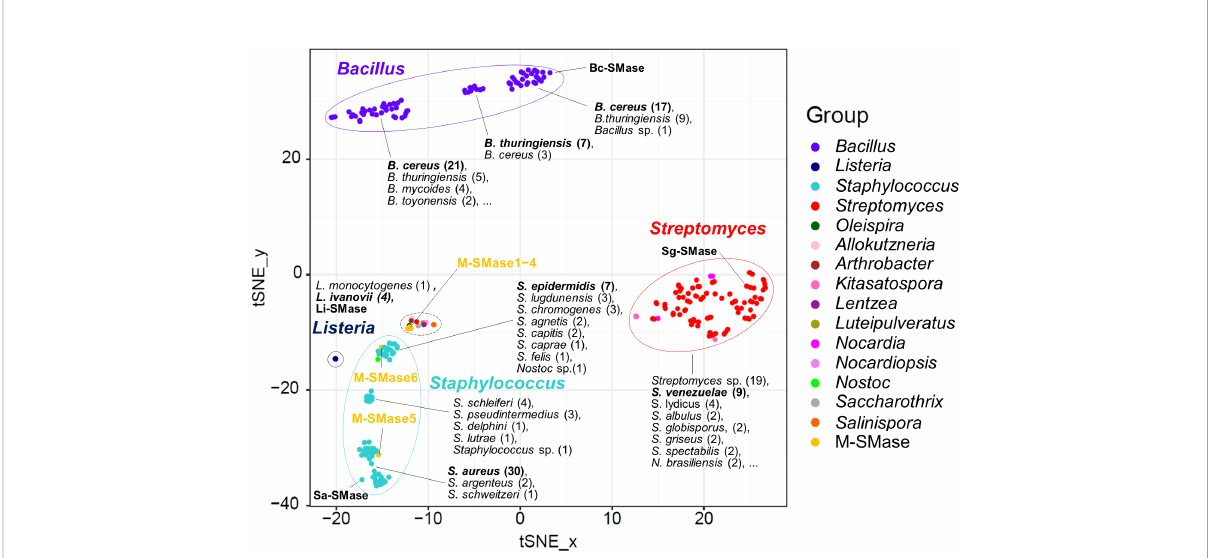
FIGURE 1 Embedding for genomic diversity of bacterial and metagenomic SMases. Protein sequence identity with four known SMases was used as a feature of t -SNE. M-SMase; metagenomic sphingomyelinase C. The number of SMases originated from a species is provided in the parentheses. A black dashed circle indicates the following species: Allokutzneria albata (1), Lentzea guizhouensis (1), Luteipulveratus mongoliensis (1), Nocardiopsis gilva (1), Oleispira antarctica (1), Psychromicrobium lacuslunae (1), Saccharothrix espanaensis (1), Salinispora arenicola (1), Salinispora tropica (1), and Streptomyces fi cellus